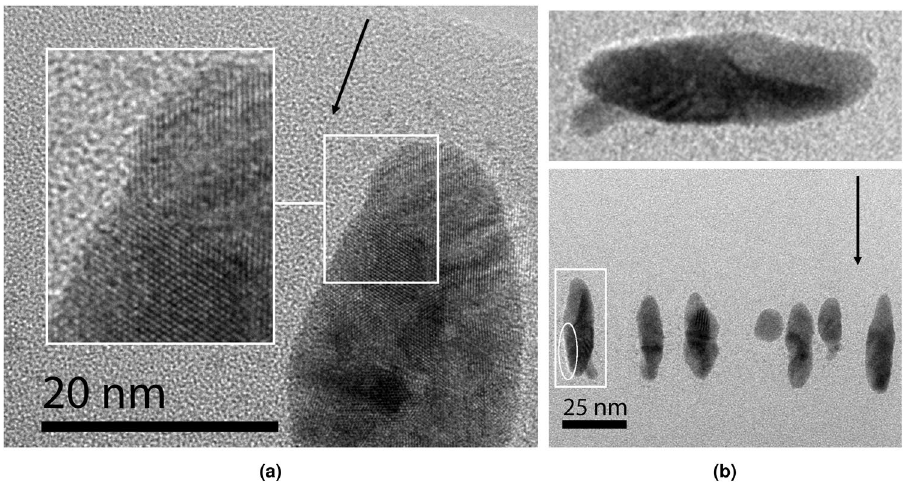
Figure 8. Cross-section HR-TEM micrographs of spherical Au NPs irradiated using 185 MeV Au ions to 13 2 a fluence of 3 × 10 cm − . Initially, the particle diameters are about 18 nm, and the fluence corresponds to around 100 impacts within the same diameter. The irradiation direction is indicated by the black arrow. ( a ) High-resolution image (magnification is × 2 000 000) showing the crystalline structure of the nanoparticle and its interface with silica. Two distinct crystalline grains with different orientations are visible from the highlighted area. ( b ) Elongated NPs showing void-free interfaces between silica and Au except for the particle highlighted by the white rectangle. The white region on one side of the particle, delimited by the ellipse, is indicative of a void or a low-density region that conforms to the shape of the NP. Shown on the top is the highlighted particle magnified. The image was taken with a × 300 000 magnification to observe the elongation of the NPs in a single